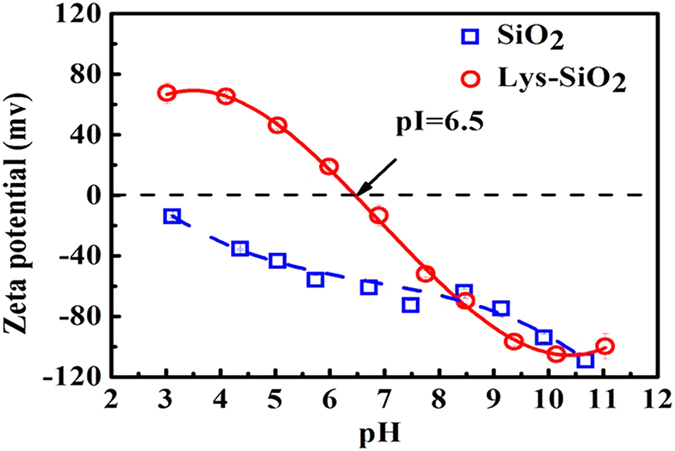
Plot of the zeta-potentials of SiO2 (square) and Lys-SiO2 particles (circles) versus pH.